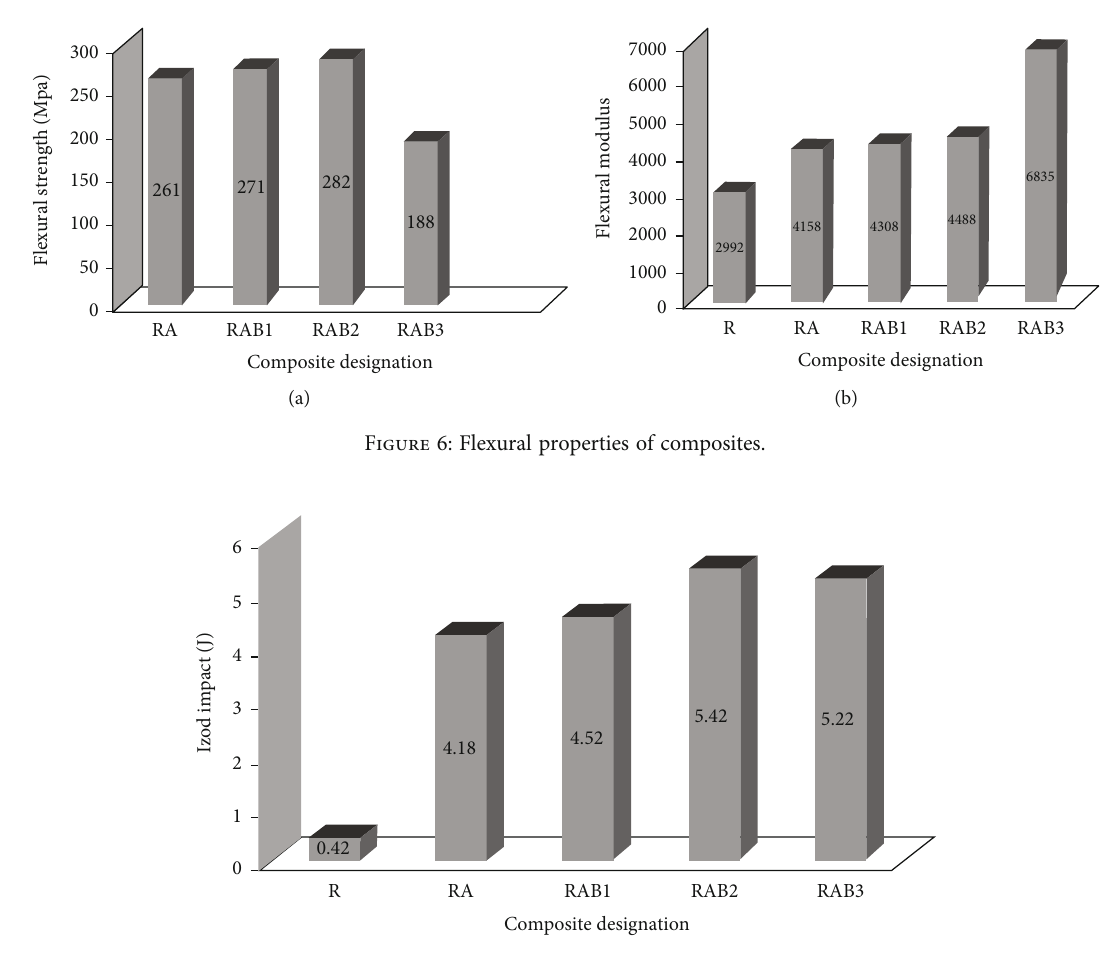
Figure 7: Izod impact of